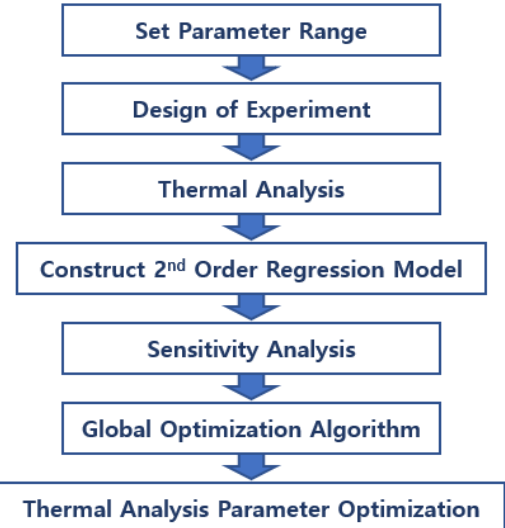
Figure 5. Procedure for estimation of optimal thermal analysis parameters.